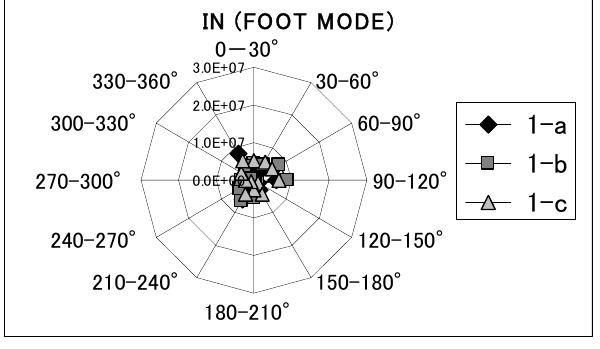
Fig. 12 Distributions of the interval RMS value of static pressure fluctuation (at the inlet of blade, FOOT MODE). The unit is [mV/s 2 ].